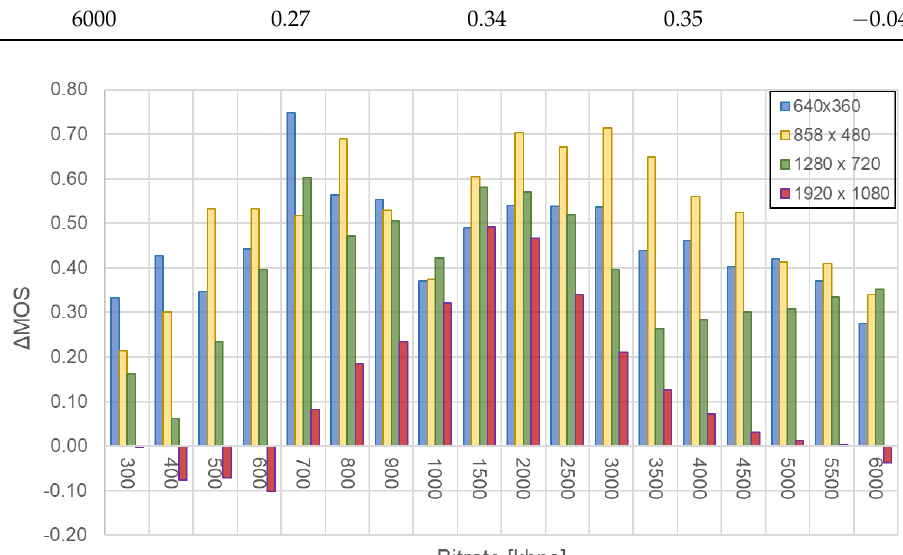
Figure 7. Difference between the results of the subjective evaluation of the H.264-encoded video (ΔMOS), conducted in the laboratory and at home, as a function of bit rate for different resolutions.